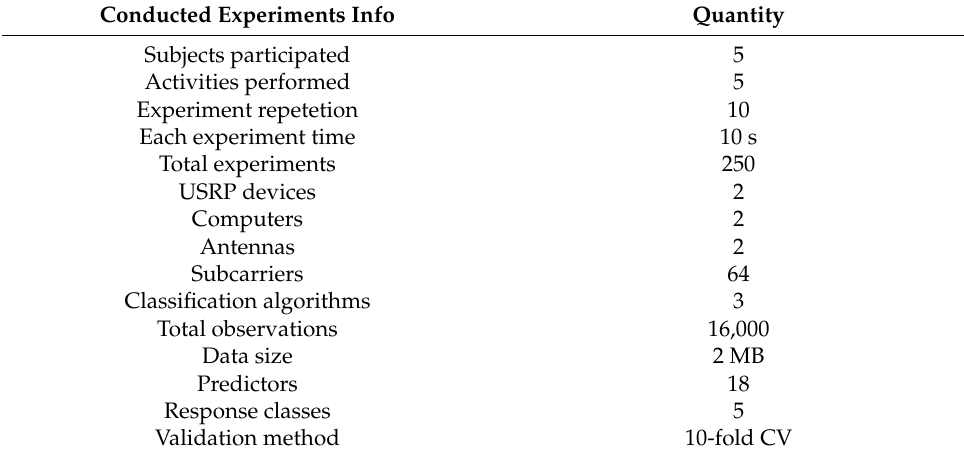
Table 5. Conducted experiments